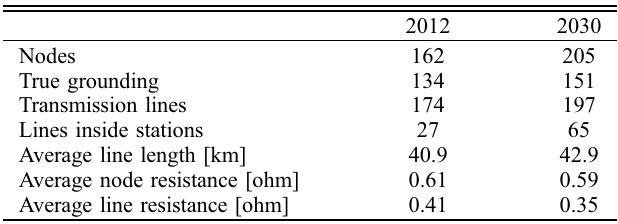
Table 3. Characteristics of the Norwegian 2012 and 2030 high- voltage power grid models. True groundings refer to nodes with a finite earthing resistance. Average node resistance is related to true groundings and contains the transformer and earthing resistances. The average line resistance refers to all lines, also within autotrans- former stations. As usual, these values correspond to the single conductor description. Lines inside stations refer to short conductor sections related to autotransformers.